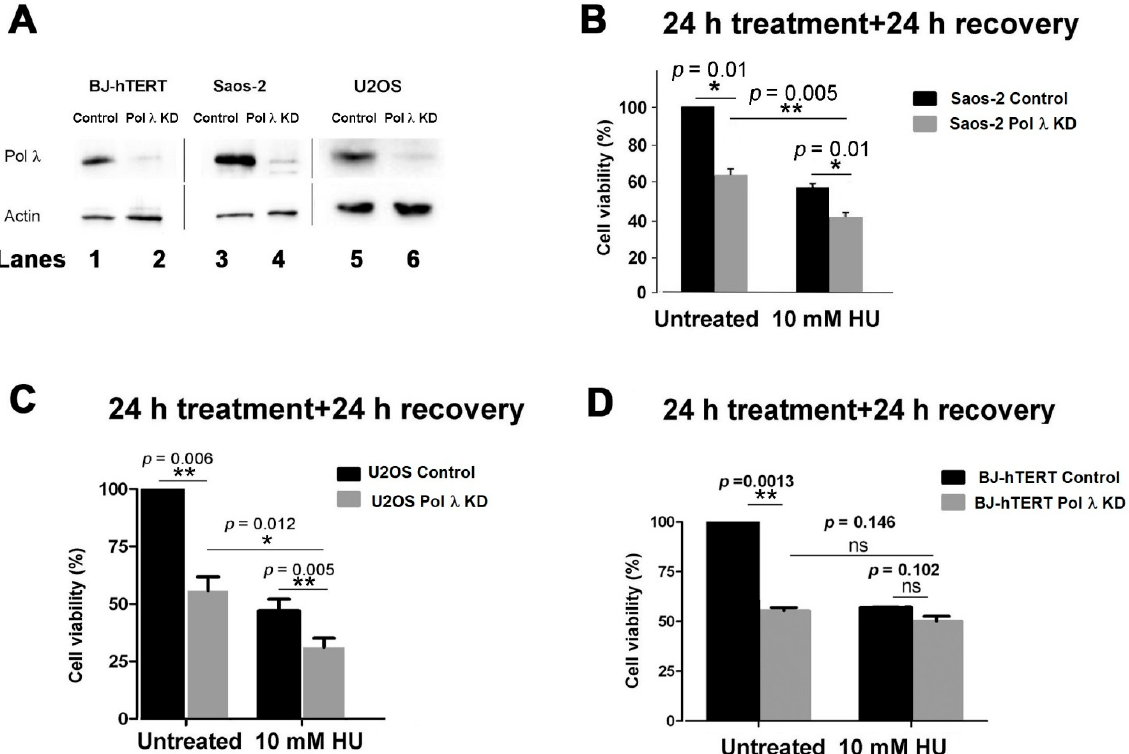
Figure 1. Silencing of human DNA polymerase λ specifically affects viability of ALT cell lines. ( A ) Western Blot analysis of Pol λ expression in BJ ‐ hTERT, Saos ‐ 2 and U2OS cell lines either treated with scrambled siRNA control (lanes 1, 3, 5, respectively), or transfected with the anti ‐ Pol λ siRNA si98 (lanes 2, 4) or the anti ‐ Pol λ SMARTpool siRNAs cocktail (lane 6). ( B ) Viability of Saos ‐ 2 cells either treated with scrambled siRNA control (black bars) or silenced for Pol λ (grey bars) was measured by MTS assays. Cells were either untreated or treated with HU for 24 h and then viability was measured after an additional 24 h recovery in the absence of treatments. ( C ) As in panel B, but with the U2OS cell line. ( D ) As in panel B, but with the BJ ‐ hTERT cell line. In all panels error bars represent ± SD of four independent experiments. χ 2 p values are shown on top of the bars. n.s., not statistically significant ( χ 2 p value > 0.02). *, χ 2 p value <0.05. **, χ 2 p value <0.01.